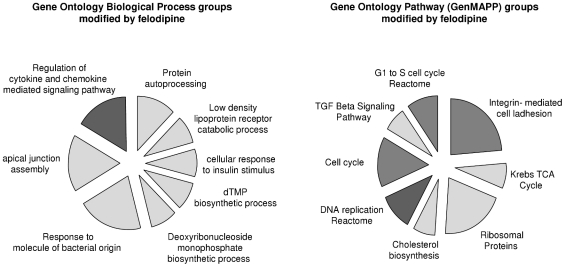
Gene ontology analysis of felodipine-induced gene expression.Mz-ChA-1 cells were incubated with 20 µM felodipine for 72 hours. RNA was then extracted and gene expression analysis was performed as indicated in the methods section. Gene Ontology (GO) analysis was performed by using the XRAY software. A set of differentially expressed genes were found to be significantly over-represented in groups of the Gene Ontology Biological Process and Pathway classes (p<0.01).